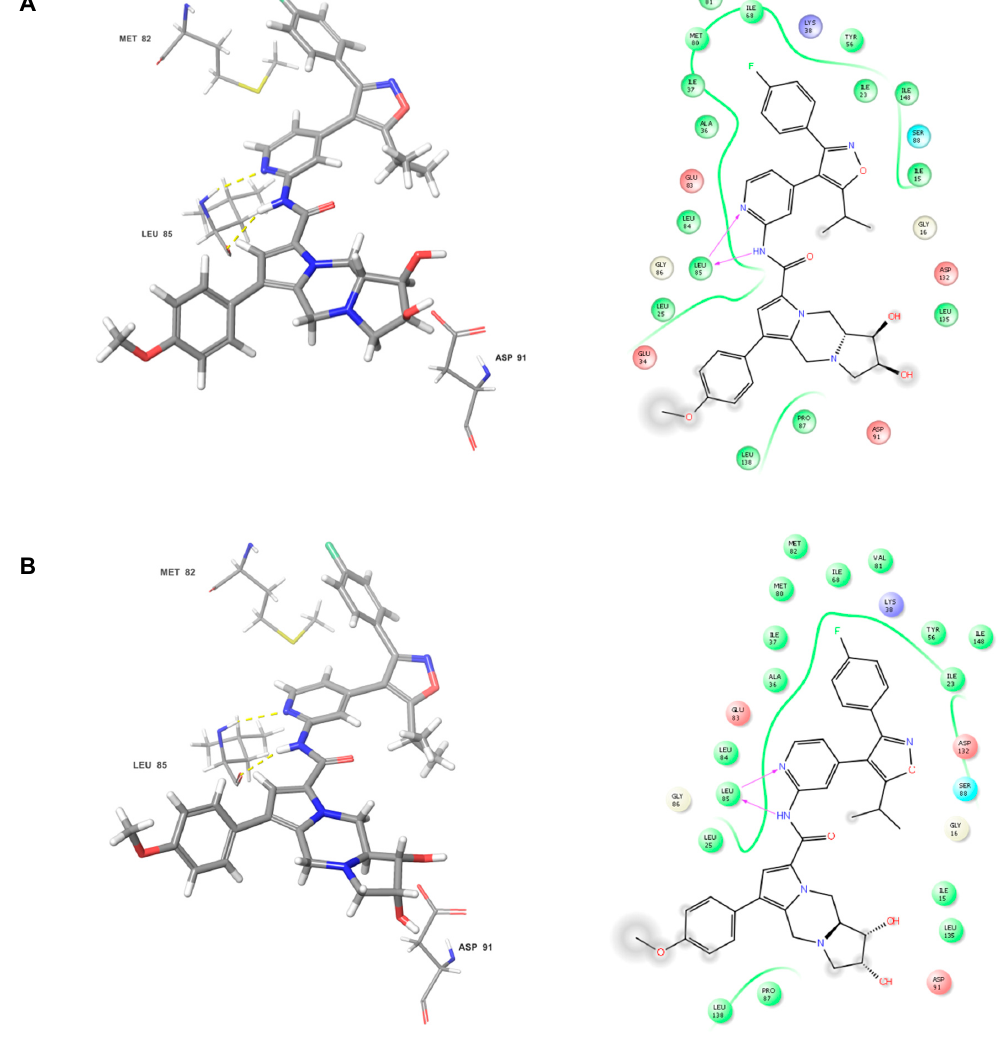
Figure 6. Binding modes of compounds 31a ( A ) and 31b ( B ) as determined by X-ray crystallographic analysis of respective ligand-protein complexes. Representation of their binding pose (left) and ligand-interaction diagram (right). Key interactions are shown.